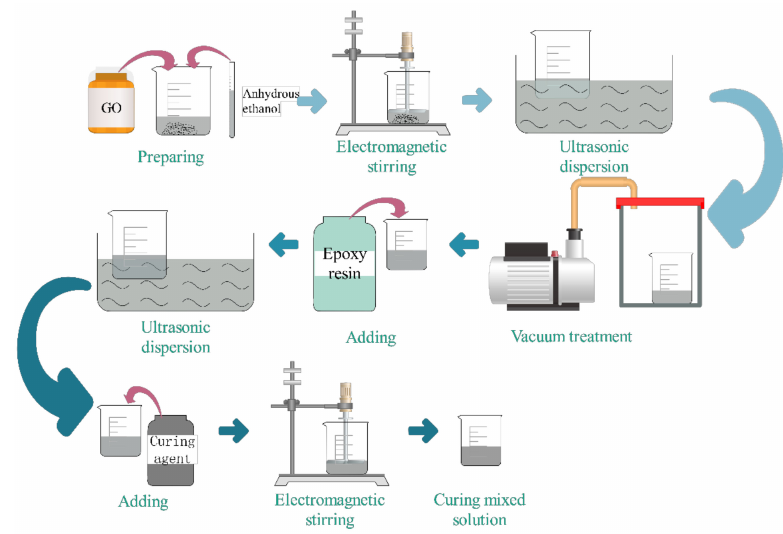
Figure 1. Preparation flow chart of curing mixed solution containing